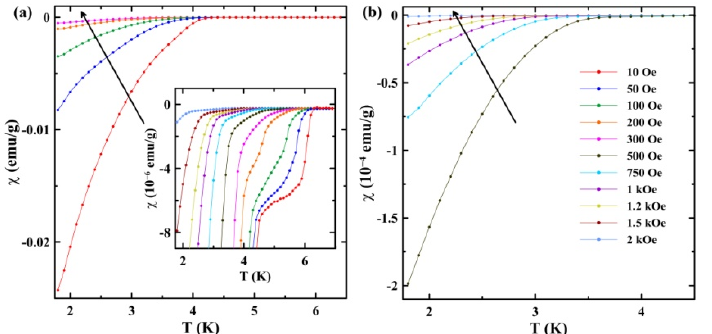
Figure 2. Temperature dependencies of the ZFC susceptibility at magnetic fields from 10 to 300 Oe ( a ) and from 500 Oe to 2 kOe ( b ). The arrows indicate the increase in fields. The inset shows scaled ZFC curves near the superconducting transitions.